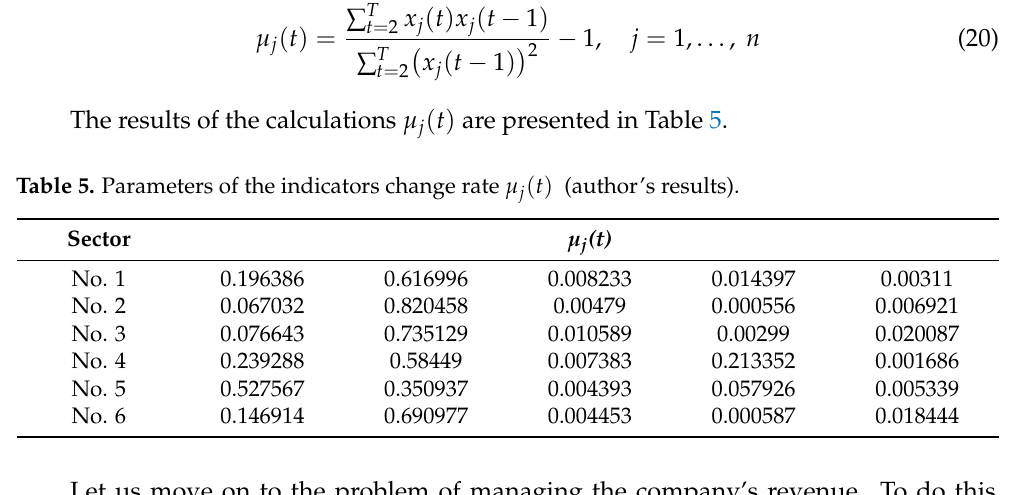
Figure 6. Comparison between real revenue and model value calculated by Formula (1) for industry No. 6, (author’s results).